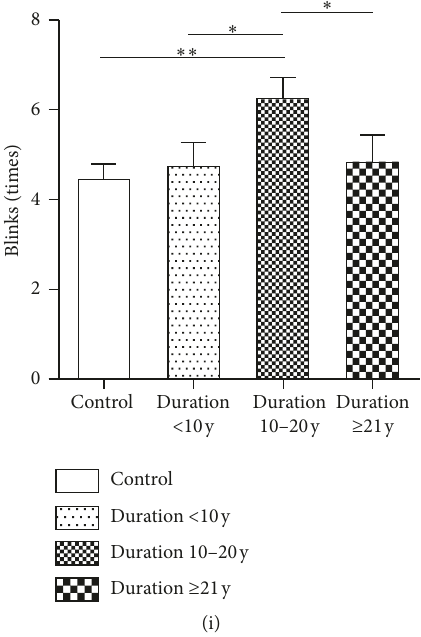
Figure 2: Comparisons of ocular surface parameters among the diabetic duration subgroups and the healthy control group. The SPEED score (a), NI-BUT (b), meiboscore (c), lipid layer thickness (d), Schirmer I test result (e), TMH (f), corneal sensitivity (g), SPK score (h), and blinks (i) were compared among the diabetic subgroups with different disease duration and the healthy control group ( ∗ P < 0 . 05, ∗∗ P < 0 . 01, and ∗∗∗ P ≤ 0 . 001).